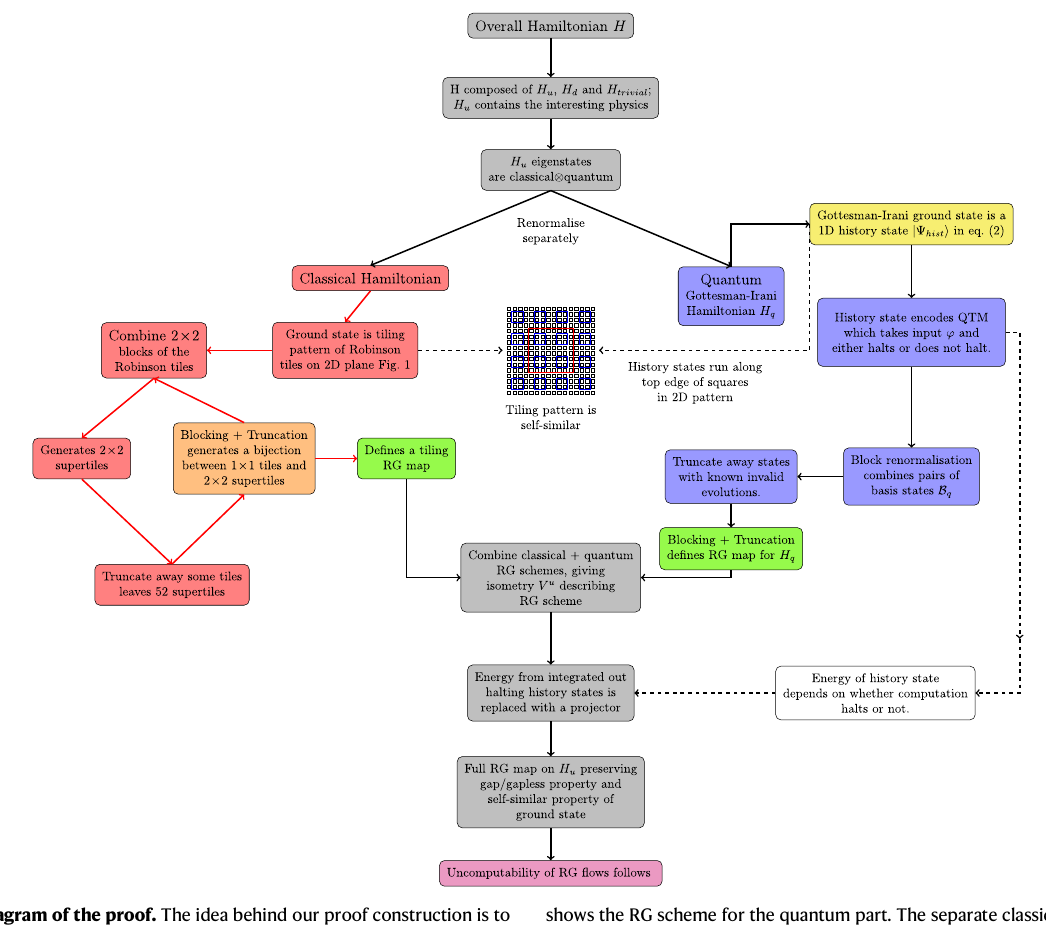
shows the RG scheme for the quantum part. The separate classical and quantum schemes are then combined (see the grey boxes) to create an RG scheme for the entire